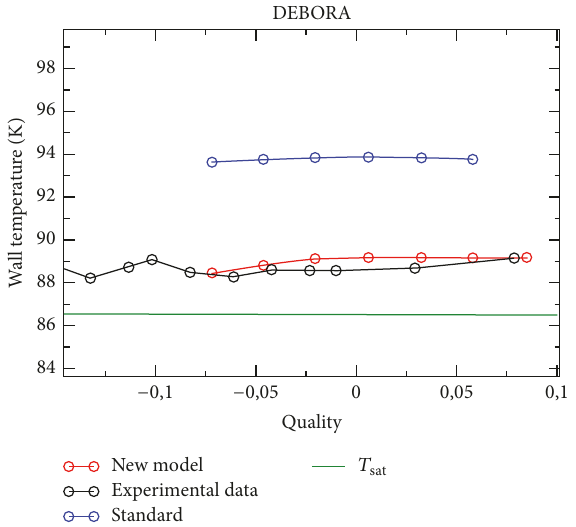
Figure 55: Wall temperature plotted against quality.